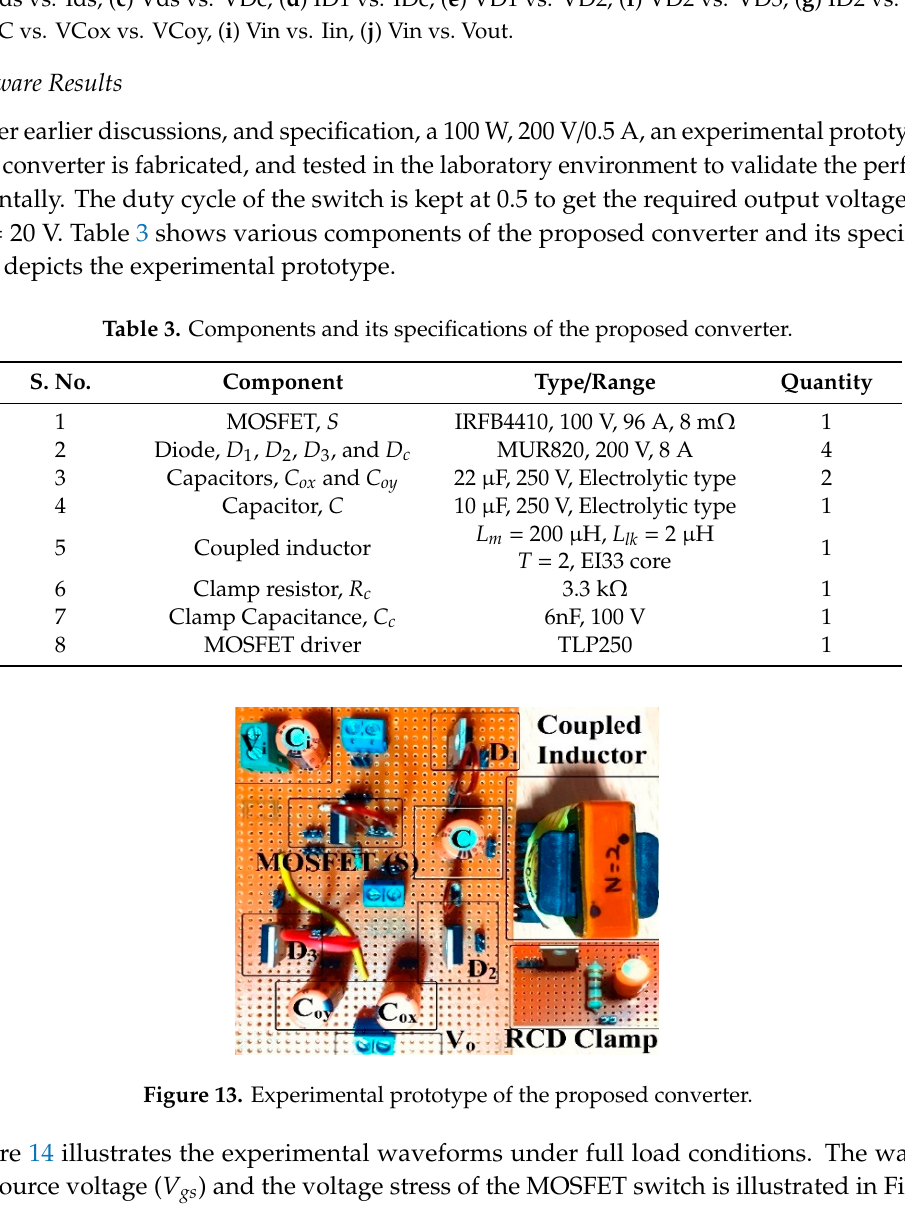
Figure 11. Simulation waveforms of the proposed converter under full load condition: ( a ) Vds vs. Vgs,